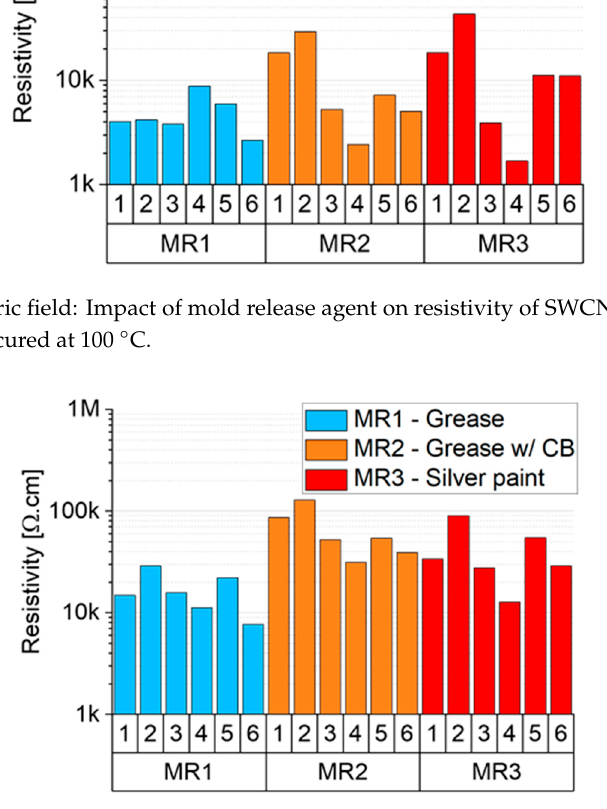
Figure 10. Without electric field: Impact of mold release agent on resistivity of SWCNT/epoxy 0.01 wt.% individual samples cured at 100 °C.